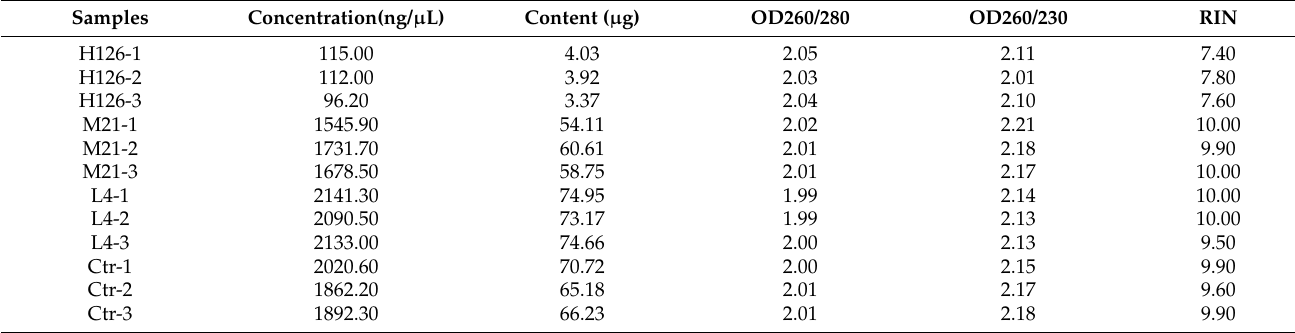
Table 1. RNA quality assessment.